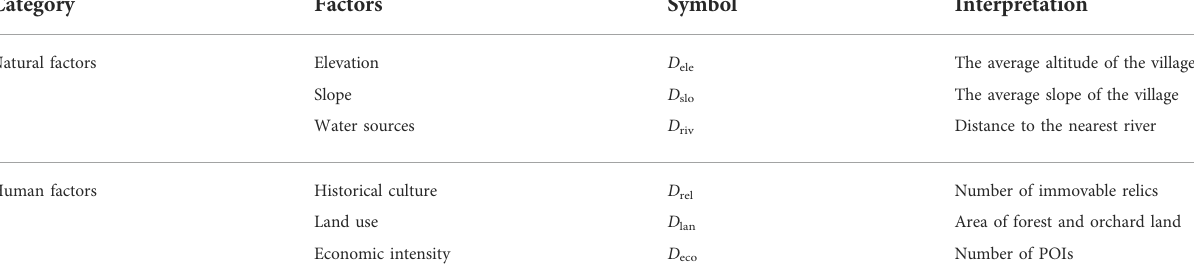
TABLE 4 Driving factors and their interpretation.